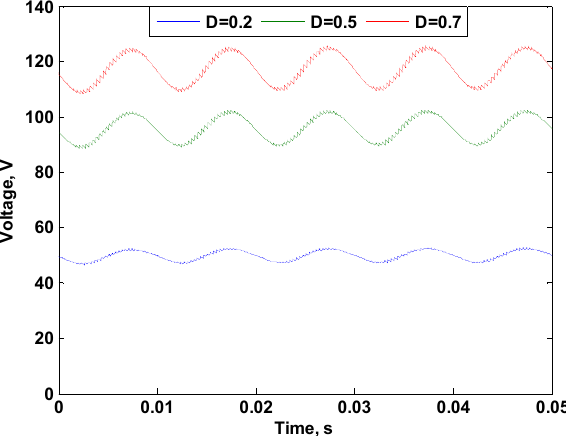
Figure 35. Experimental output voltages at the load terminals at the adopted duty ratios.